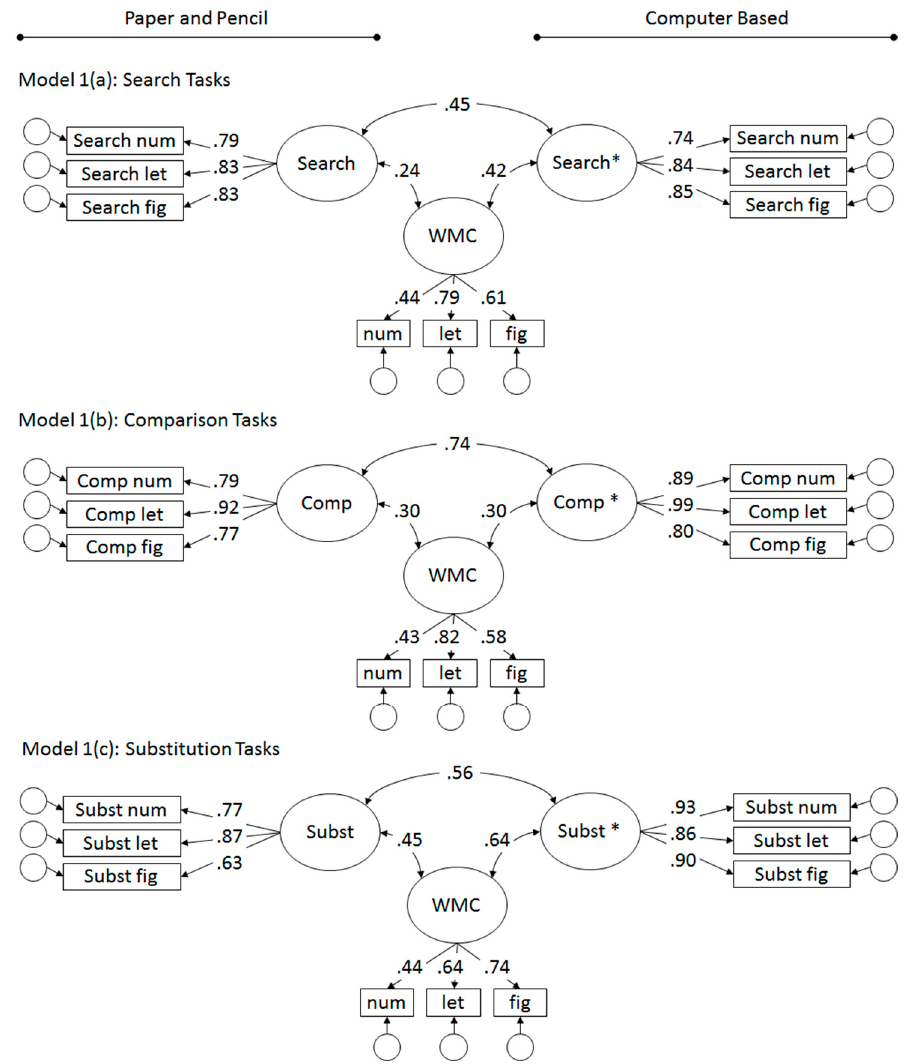
Figure 2. Relations of single task paper-and-pencil (PP) and CB speed factors across mode of administration, and with Working Memory Capacity (WMC), separate for 1(a) Search, 1(b) Comparison, and 1(c) Substitution tasks.